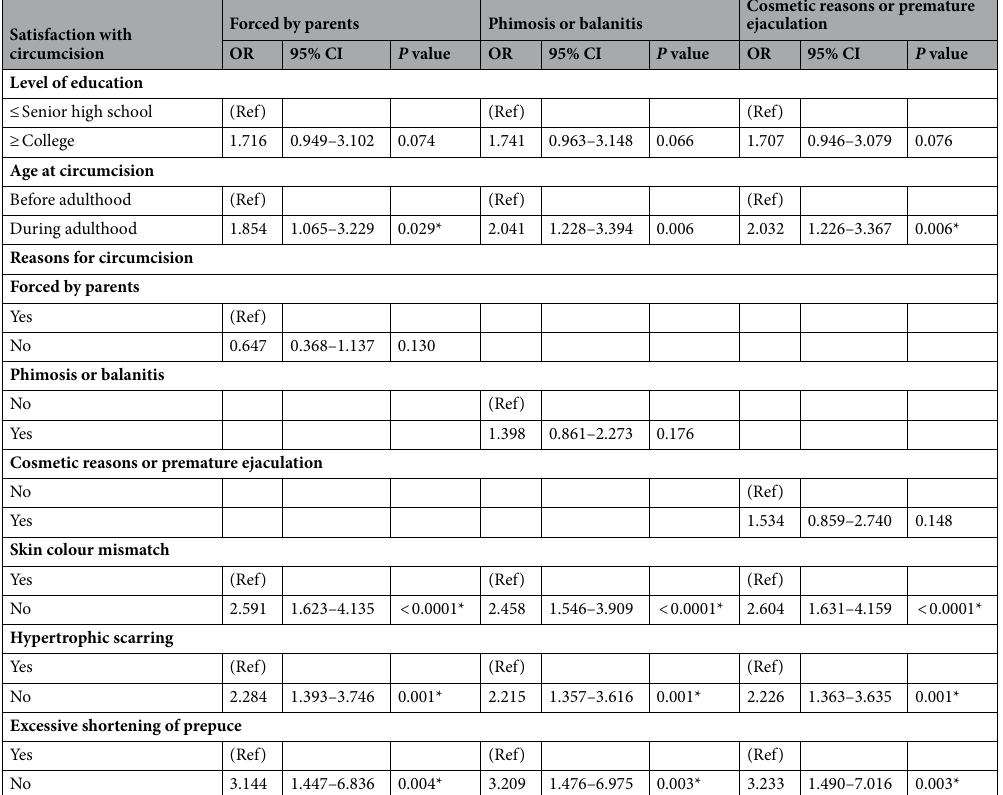
Satisfaction with